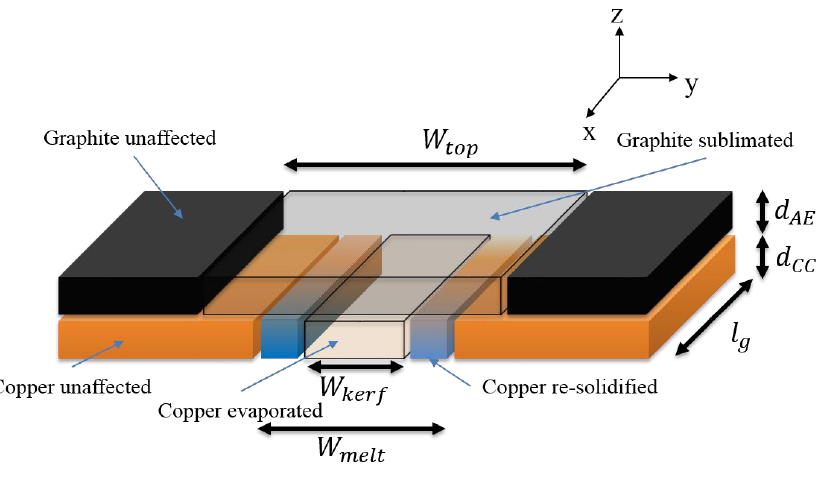
Figure 2. Definition of areas for cutting efficiency.